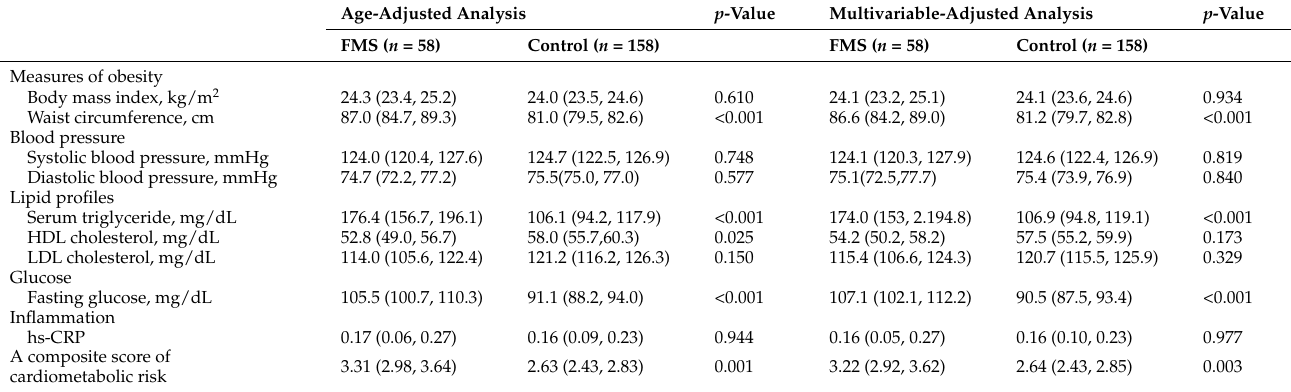
cholesterol level was lower in the FM group than in the control group in the age-adjusted analysis; however, the difference was not significant in the multivariable analysis. No significant differences in the blood pressure, LDL cholesterol, and hs-CRP levels were observed between the two groups. Table 2. Cardiometabolic profiles among female fibromyalgia syndrome (FMS) compared with those without